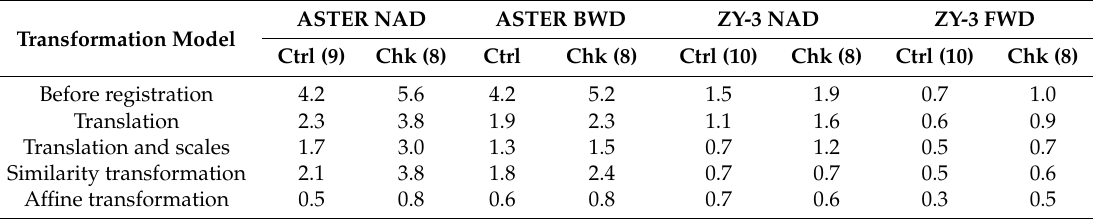
Table 1. Average distances (distance is the absolute residual in Equation (2)) between feature lines and projected feature points before and after registration using different transformation models (unit: pixel).